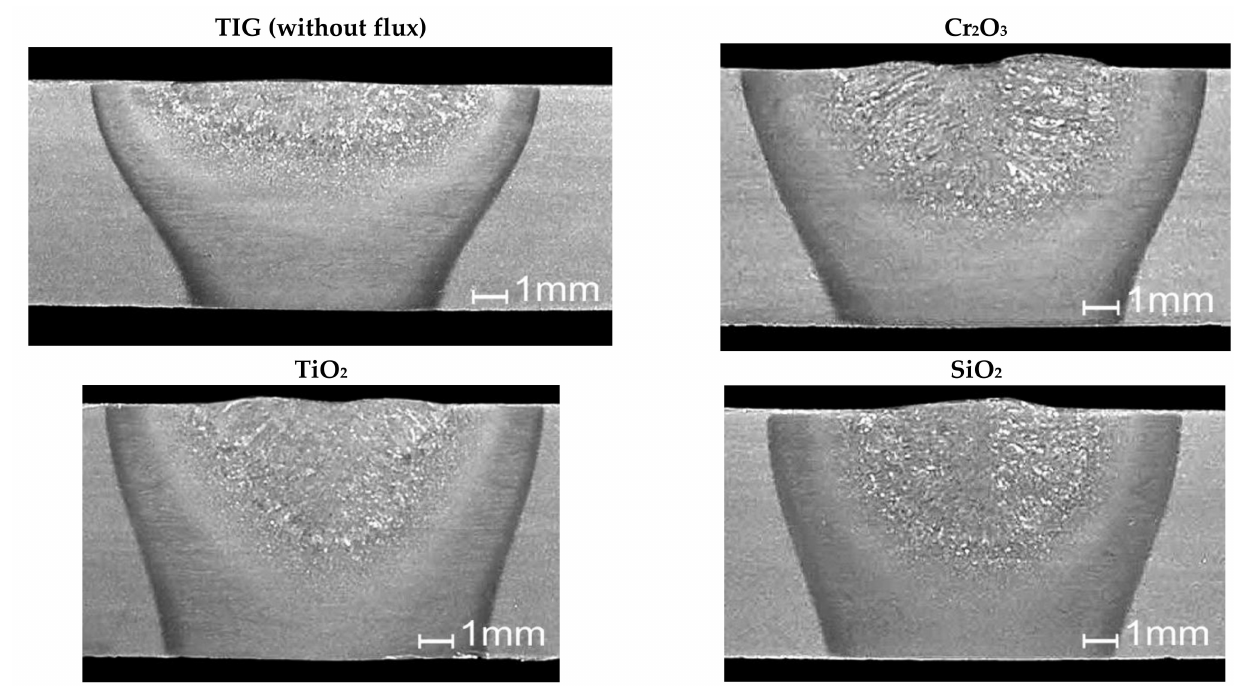
Figure 9. Macrostructure of the TIG and A-TIG welds on steel WELDOX